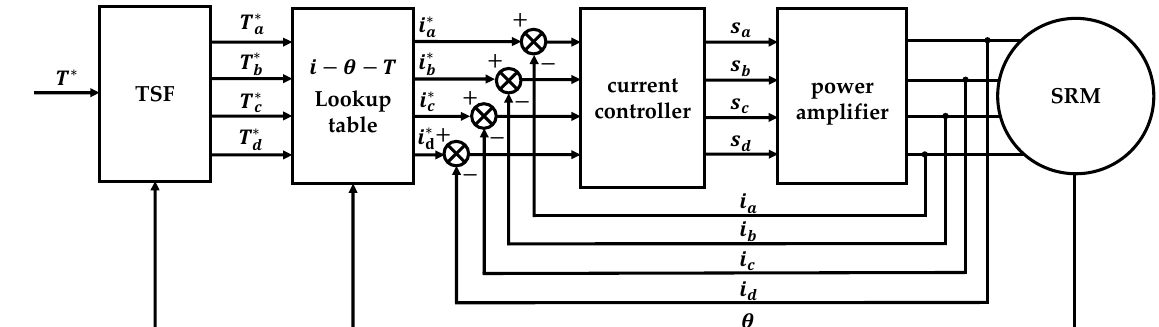
Figure 1. Block diagram of TSF based torque control scheme.